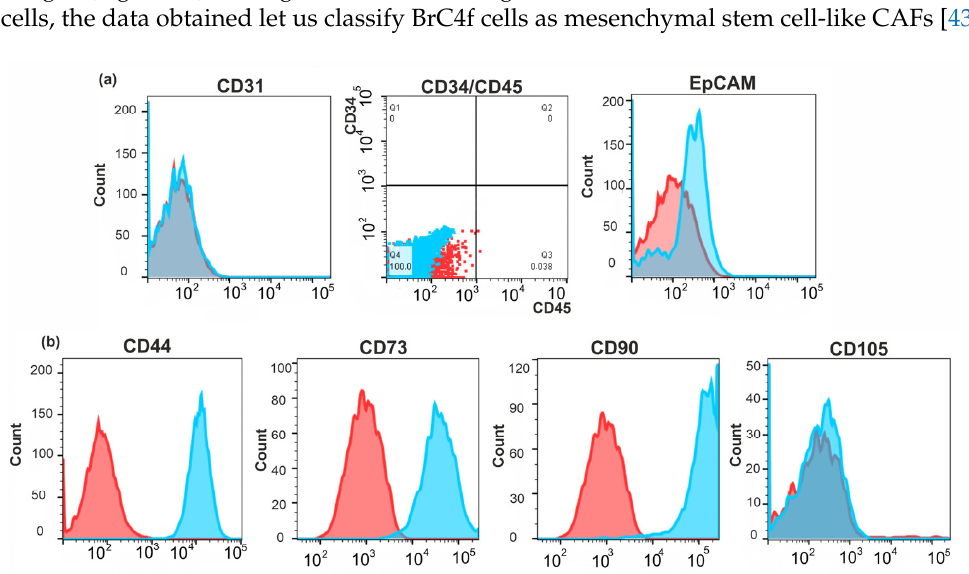
Figure 4. Markers used in the identification of profiling CAFs by flow cytometry. ( a ) Negative control CD34—transmembrane phosphoglycoprotein; CD45—protein tyrosine phosphatase, receptor type, CD31—platelet endothelial cell adhesion molecule and EpCAM–epithelial cell adhesion molecule; ( b ) CD90—membrane GPI-anchored protein with one Ig V-type superfamily domain; CD73—ecto-5- nucleotidase; CD105—surface endoglin; C. Red—negative control,